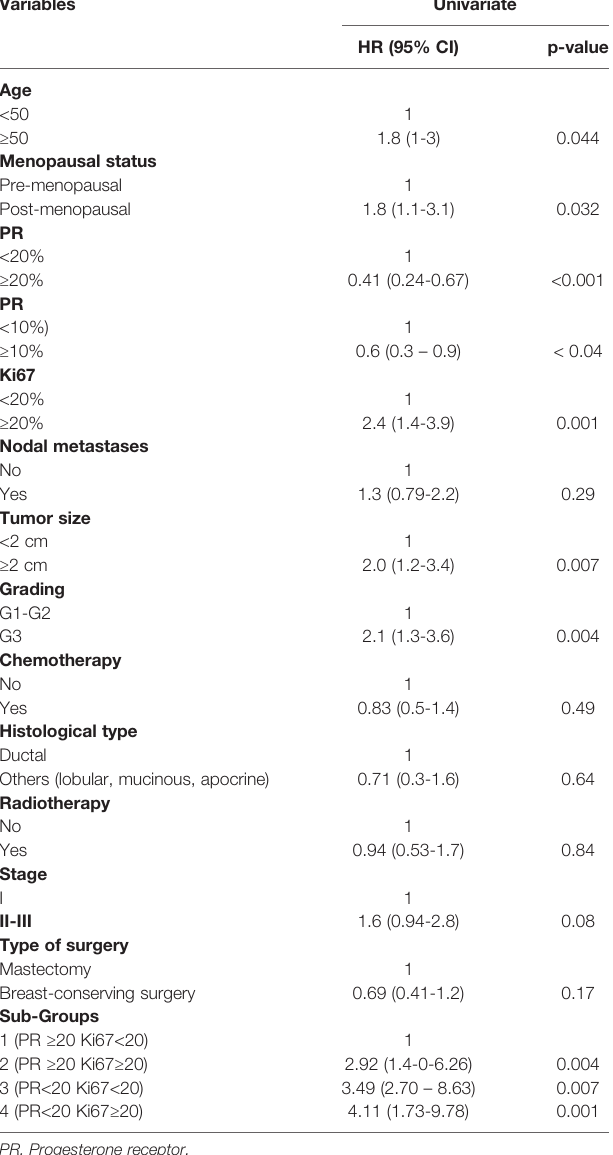
TABLE 3 | Prognostic variables for breast cancer speci fi c survival in univariate analysis.